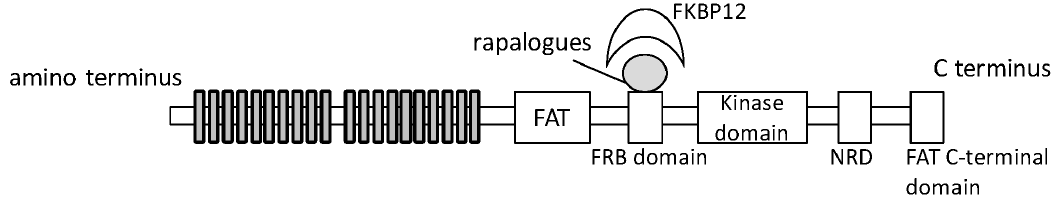
Figure 3. Interaction of mTOR, rapalogues, and 12-kDa FK506- and rapamycin-binding protein (FKBP12) m TOR contains 2549 amino acids. Rapalogues, mTOR inhibitors, form a complex with FKBP12 that binds to the FKBP-rapamycin binding (FRB) domain [4].